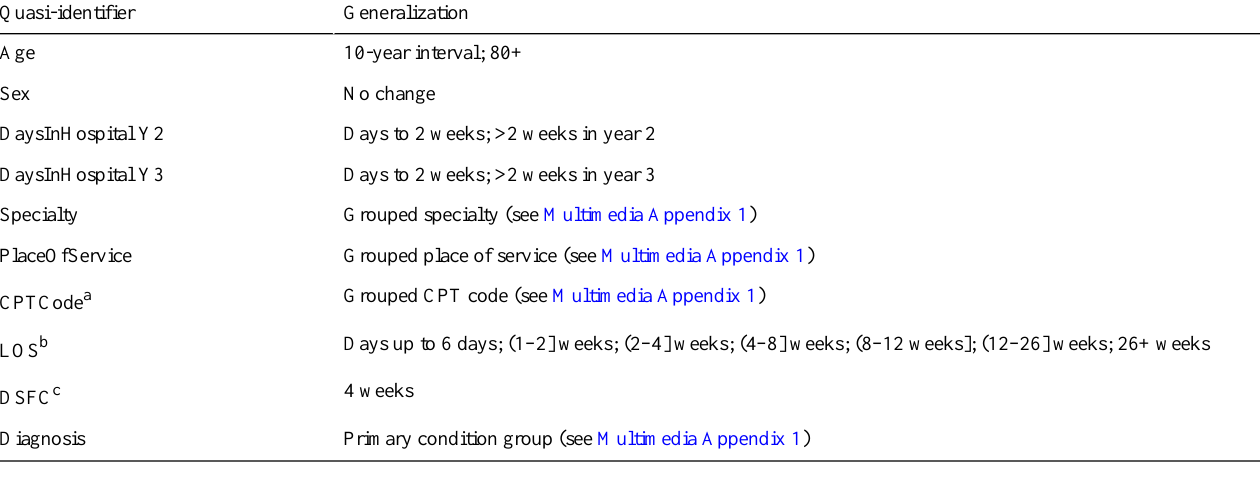
Table 5. Final generalizations in the dataset.